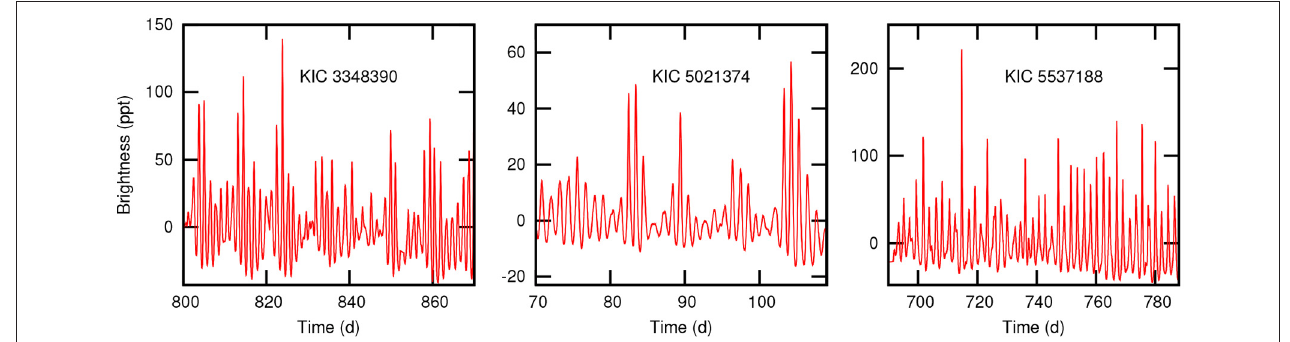
FIGURE 3 | A selection of ASYM (GDORA) γ Dor light curves. The fractional brightness variation is in parts per thousand.